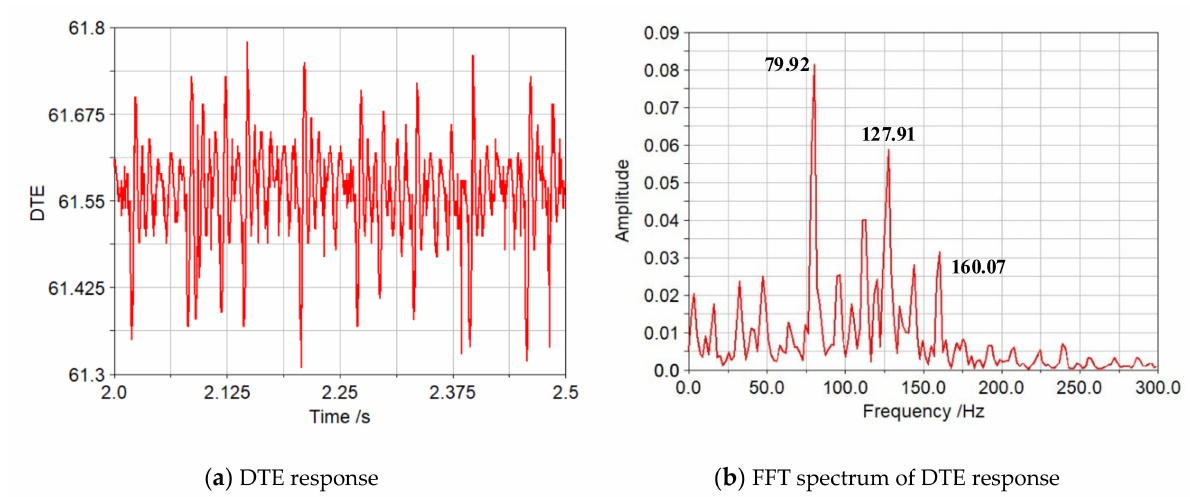
Figure 11. Virtual prototyping